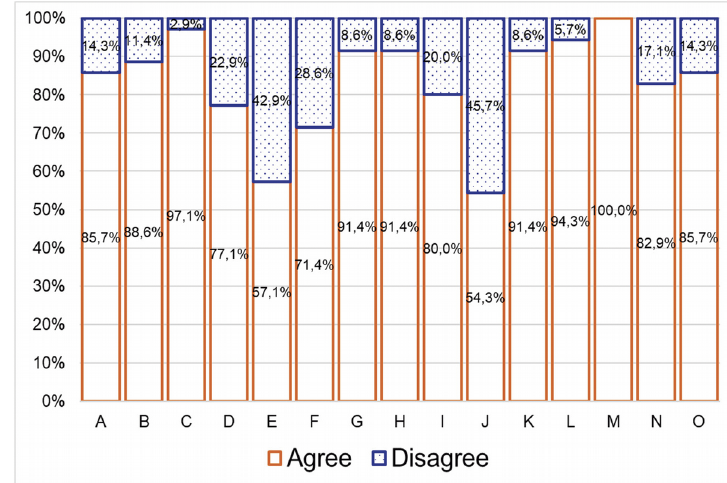
Figure 7. Survey 2 results: perception of the applicability of the tools, their use, and the information of the